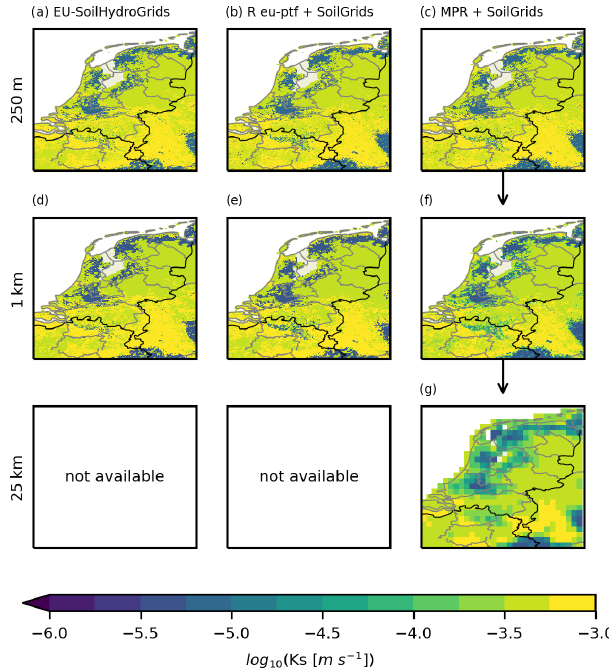
Figure 4. Saturated hydraulic conductivity values for the Nether- lands generated for different scales and different tools: (a) EU- SoilHydroGrids (Tóth et al., 2017) at 250m, (b) TF16 (Tóth et al., 2015) applied on SoilGrids (Hengl et al., 2017) using R package euptf at 250m, (c) TF16 (Tóth et al., 2015) applied on SoilGrids us- ing MPR (Hengl et al., 2017) (Weynants and Tóth, 2014) at 250m, (d) EU-SoilHydroGrids (Tóth et al., 2017) at 1km, panel (e) is the same as (b) but at 1km, (f) TF16 (Tóth et al., 2015) applied on SoilGrids250m and scaled to 1km using MPR, and (g) TF16 (Tóth et al., 2015) applied on SoilGrids250m and scaled to 25km using